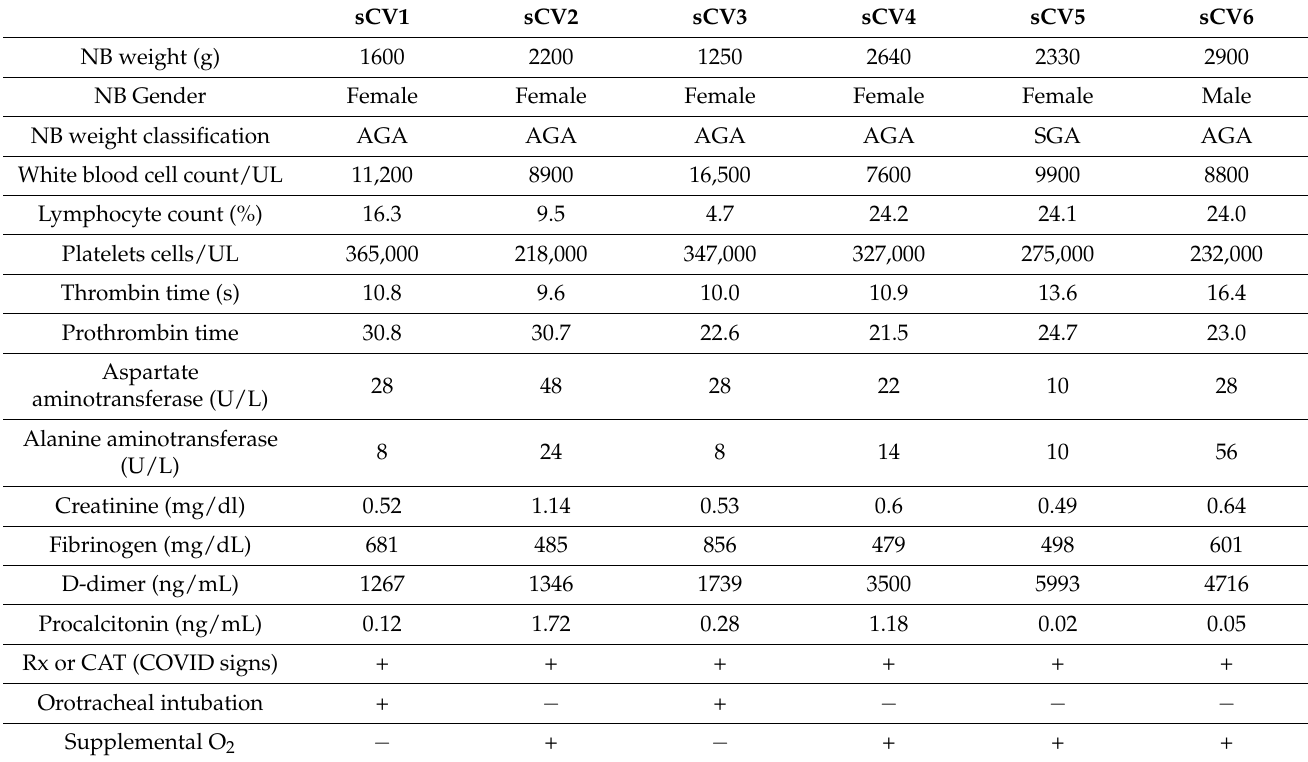
3.1. vWf Is Overexpressed in the Endothelium of Decidua and Chorionic Villi of Placentas Derived from Women with COVID-19 according to Disease Severity Placentas from control women show a clear immunofluorescence staining for vWf in decidual endothelium (Figure 1a,b) and chorionic villi (Figure 2a,b). In the placenta of women with COVID-19, staining of vWf significantly increases in the decidual and chorionic villi endothelium. The most abundant vWf stain was observed in severe cases. Hence, this result indicates that the placental endothelium of women with COVID-19 displays a characteristic frequently observed in a thrombotic